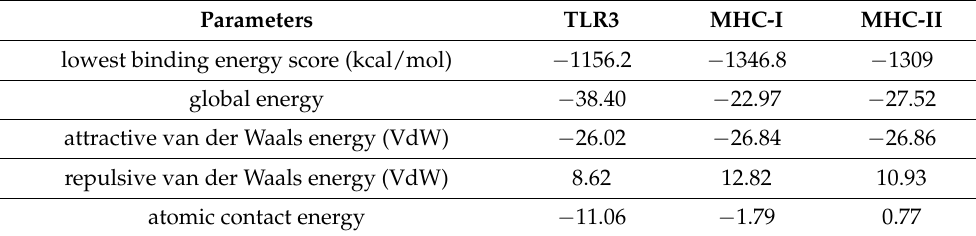
Figure 11. The ligand–receptor docked complex:( A , C , E ) the docking interaction of the vaccine construct (red color) with the TLR-3, MHC-I, and MHC-II receptors (other colors), as assessed using ClusPro software;( B , D , F )the docking interaction of the vaccine construct (red color) and TLR-3, MHC-I, and MHC-II receptors (other colors), as assessed using PatchDock [119]. Permission and copyright © from Frontiers in Immunology (www.frontiersin.org (accessed on 20 October 2021)). Table 1. Static interactions of vaccines with TLR3, MHC-I, and